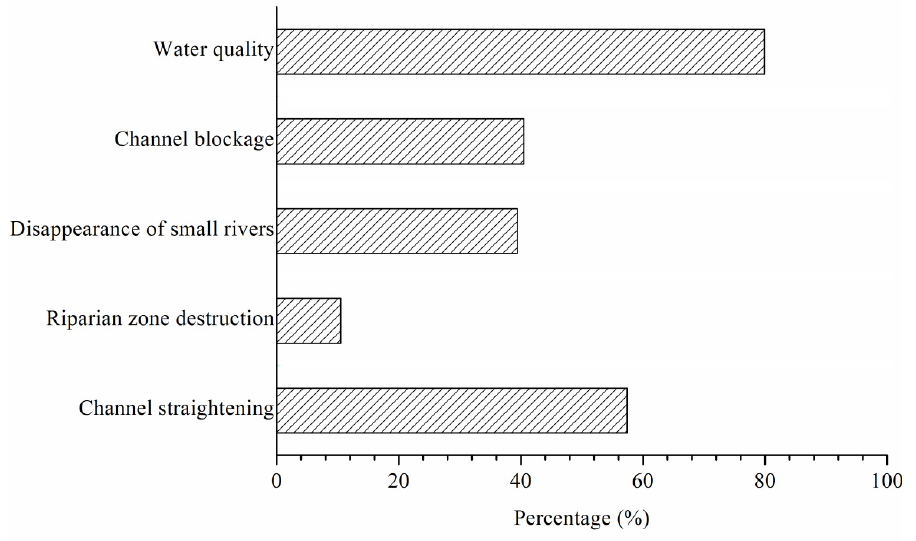
Figure 5. Respondents’ awareness of river network